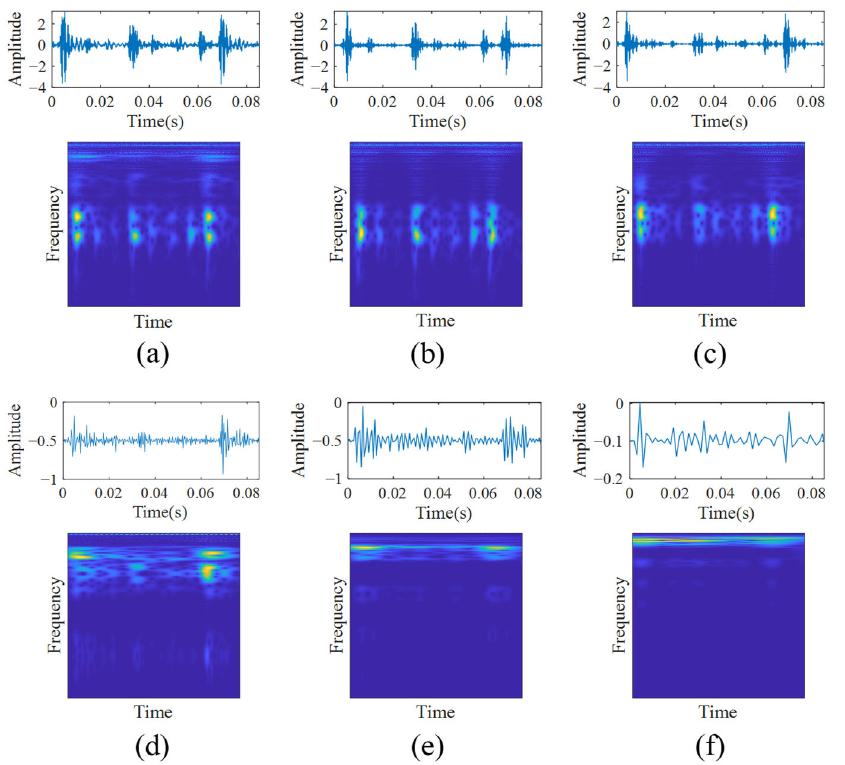
Figure 9. Signal waveform and TFR map: ( a ) raw signal; ( b ) detailed signal D1; ( c ) detailed signal D2; ( d ) detailed signal D3; ( e ) detailed signal D4; ( f ) approximate signal A4. Table 2. Structure and hyperparameter selection for the multifeature fusion ViT model and two benchmark models.